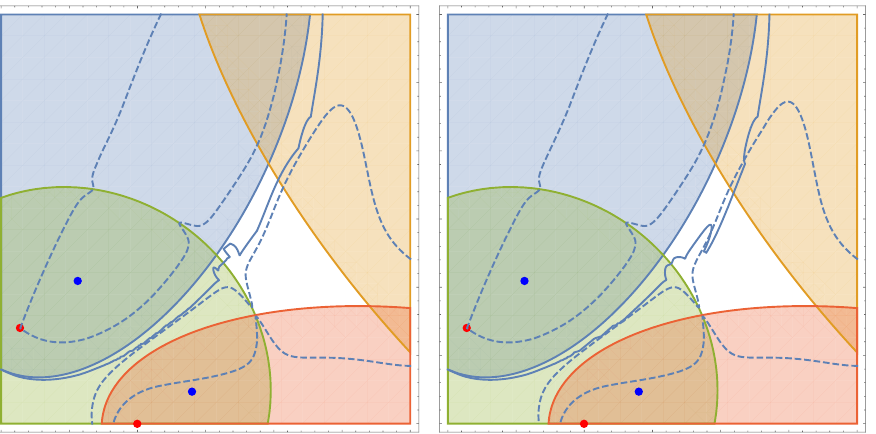
Figure 9. A deformation that satis(cid:12)es the complex pole constraint, described in section 3.3.2, prevents that an E-surface (cid:17) has zeros in the integration space. Left: a deformation rescaled by the complex pole constraint. Right: a deformation that violates the complex pole constraint. The integrand has poles where the dashes line meets the solid